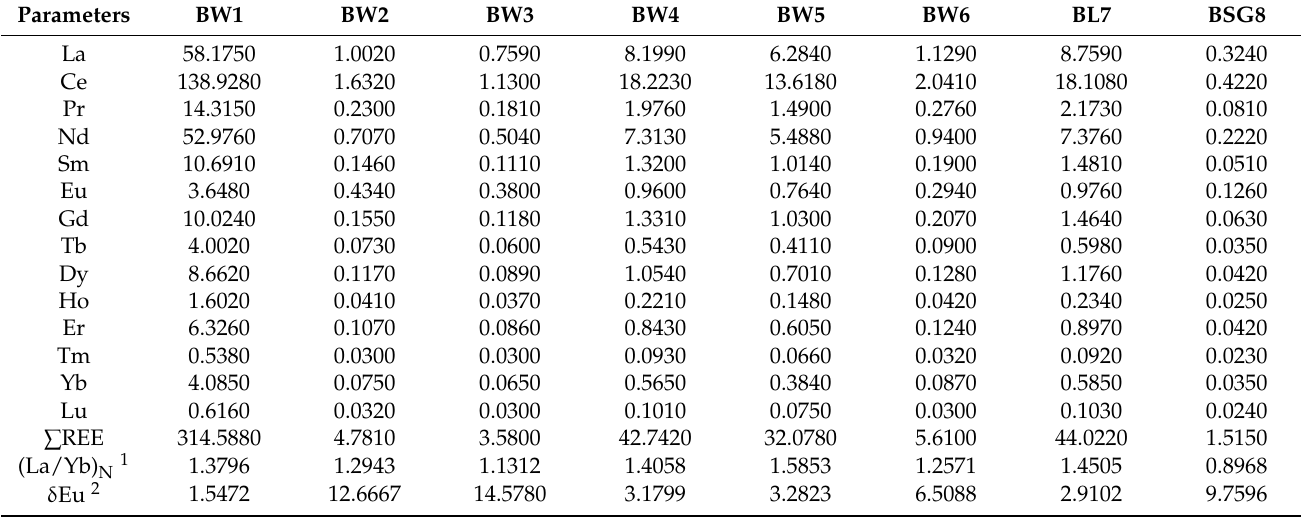
Table 3. Concentration of REE( µ g/L) in MBW and peripheral